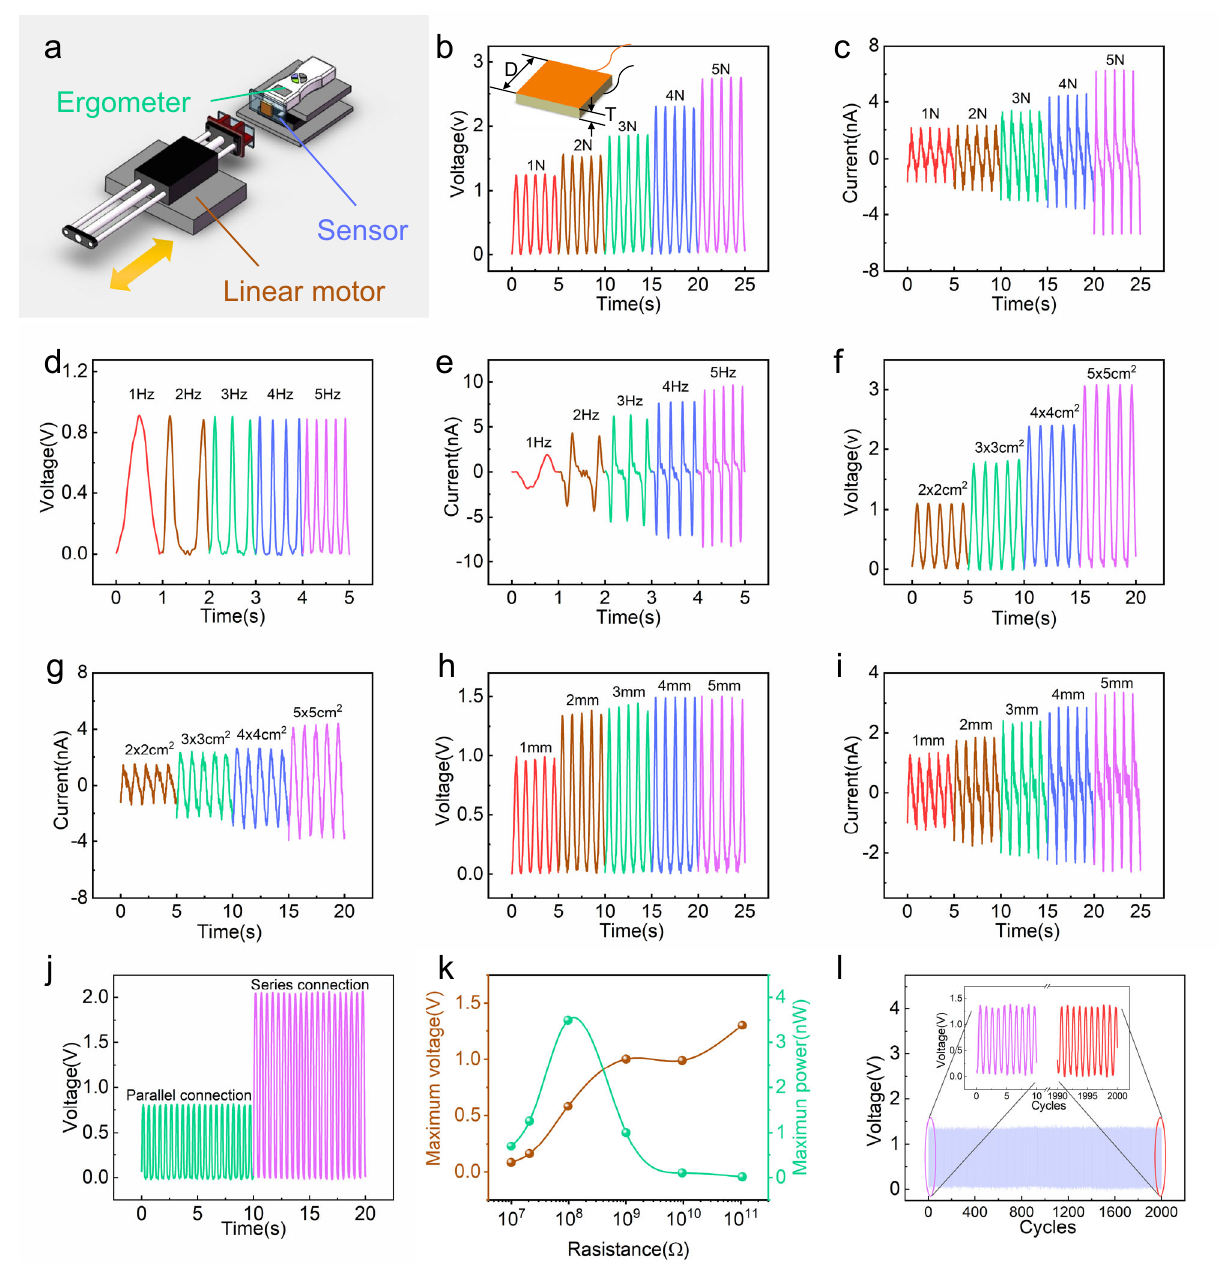
Fig. 2 Electrical characteristics of the TENG sensors. a Platform with adjustable pressing force and frequency consists of a linear motor, ergometer and sensor. b , c The open-circuit voltage and short-circuit current obtained by pressing the sensor at 1 Hz frequency with different forces (from 1 N to 5 N). Inset: schematic diagram of the sensor size. d , e The open-circuit voltage and short-circuit current output of the sensor at the pressing frequency (from 1 Hz to 5 Hz) with a force of 5 N. f , g Open-circuit voltage and short-circuit current output obtained from sensors with different areas at a frequency of 1 Hz with a force of 5 N. h , i The open-circuit voltage and short-circuit current output obtained from sensors with different thicknesses at a frequency of 1 Hz with a force of 5 N. j The open-circuit voltage for two sensors placed in series and in parallel. k The maximum output power and maximum voltage curves for the triboelectric sensor used as a power supply with different external load resistances (ranging from 10 7 to 10 11 Ω ) with a force of 5 N at a frequency of 2 Hz. l Mechanical durability test for up to 2000 press-release cycles. Inset: the voltage signals generated for the initial 10 s and the fi nal 10